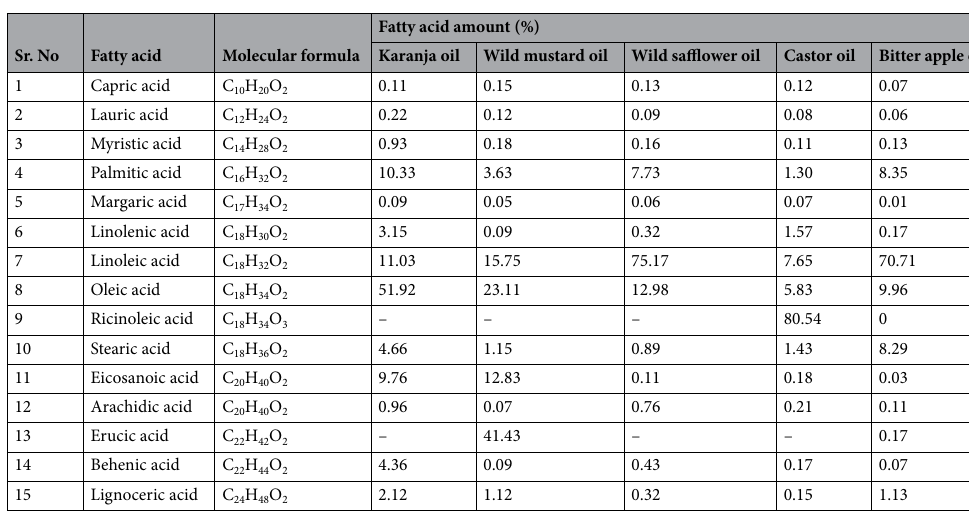
Table 10. Fatty acid composition of various oils used in the present